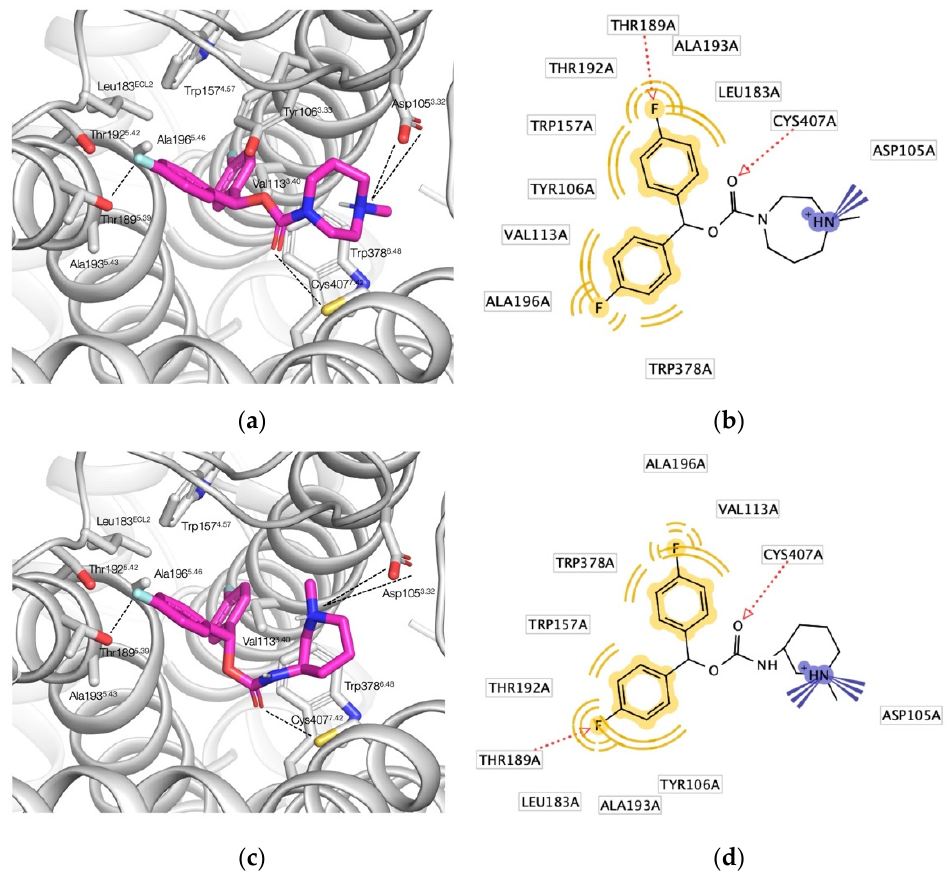
Figure 4. Docking poses for selected hits (carbons in magenta) in the orthosteric binding site of M 1 (PDB 5CXV) with interacting amino acid residues and key polar interactions highlighted (dashed lines) and the corresponding 2D pharmacophores: ( a ) docking pose of 2 ; ( b ) 2D pharmacophore of 2 ; ( c ) docking pose of ( R )- 7 ; Tyr106 3.33 and Tyr404 7.39 omitted for the sake of clarity; ( d ) 2D pharmacophore of ( R )- 7 .